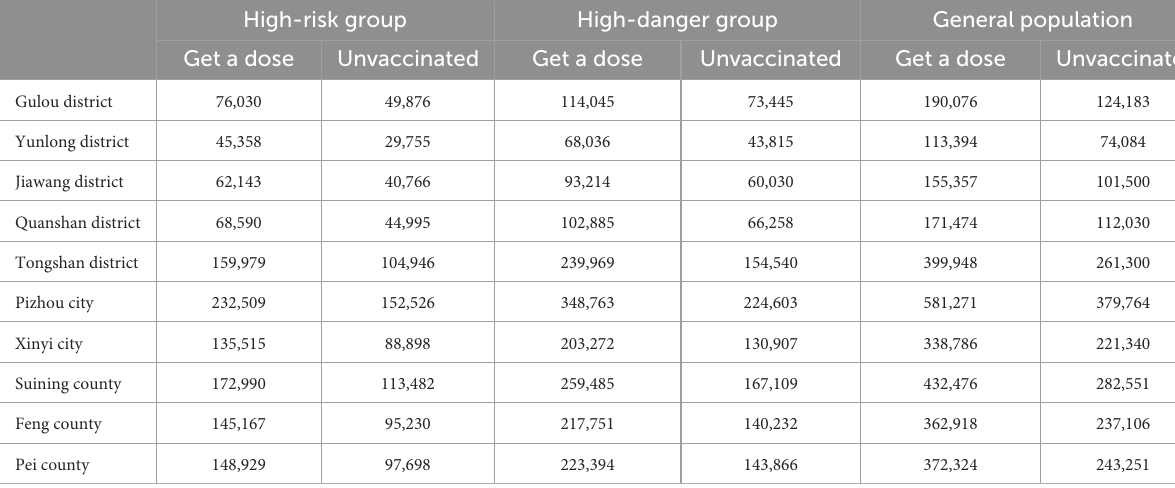
TABLE 5 Actual number of people to be vaccinated in each region.